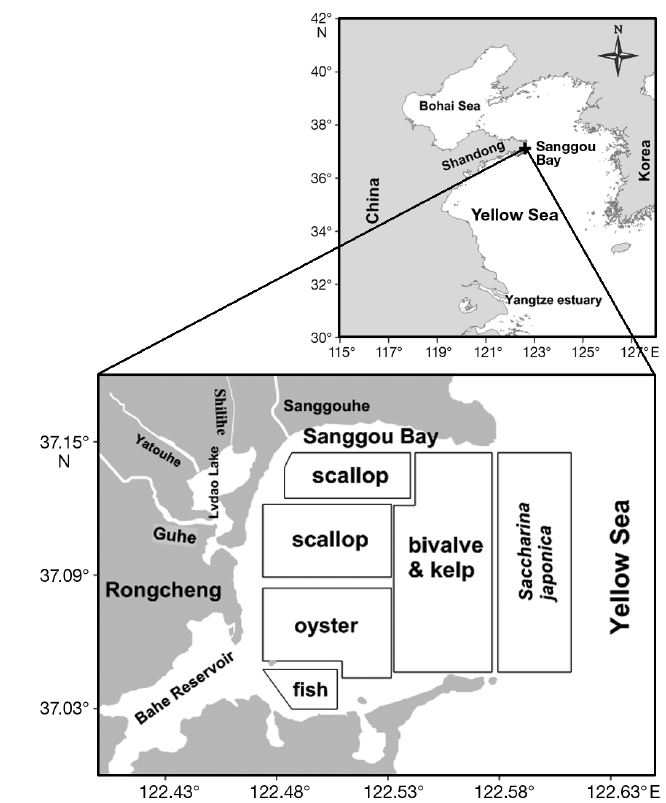
Fig. 1. Location of Sanggou Bay, China, and aquaculture activities, showing the regions of kelp ( Saccharina japonica ) monoculture; scallop, oyster, and fish monoculture; and multi- species